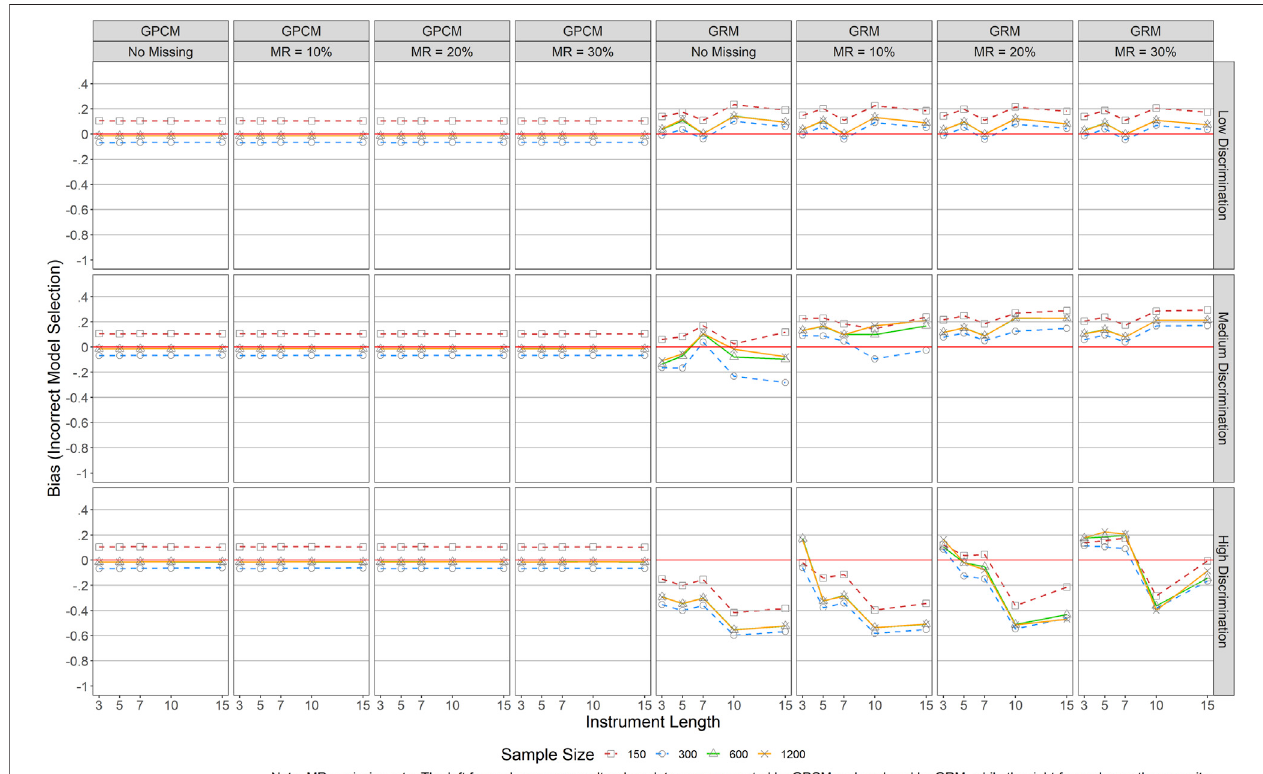
FIGURE8| BiasResultsofPersonParameterEstimationsforBothGRMandGPCM(IncorrectModelSelection).Note.MR (cid:1) missingrate;Theleftfourcolumnsare results when date were generated by GPCM and analyzed by GRM, while the right four columns the opposite.